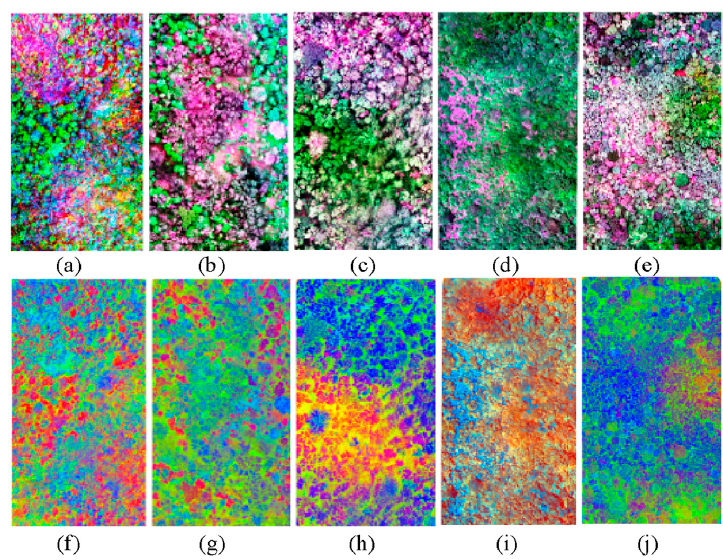
Figure 2. Color composites of each plot at the study area in Costa Rica. Plots: ( a , f ): plot #1, ( b , g ): plot #2, ( c , h ): plot #3, ( d , i ): plot #4, ( e , j ): plot #5. Top row: R (red), G (green) and blue (B) band composites. Bottom row: tasseled cap (R), principal component (first band, G) and texture analysis (mean, B) composites.